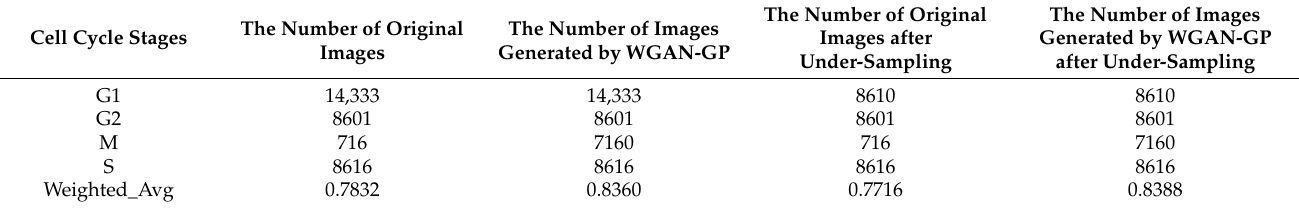
Table 4. Four-stage classification results for the original images, the images generated by WGAN-GP, the original images after under-sampling, and the images generated by WGAN-GP after under-sampling. Cell Cycle